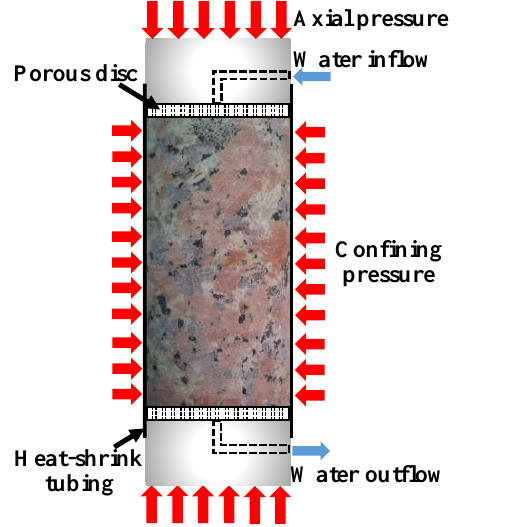
p w = 8.0 MPa Figure 5. Fracturing patterns of NRG01 granite samples affected by water pressures under fixed confinements ( σ 3 = 5.0 MPa and 10.0 MPa).